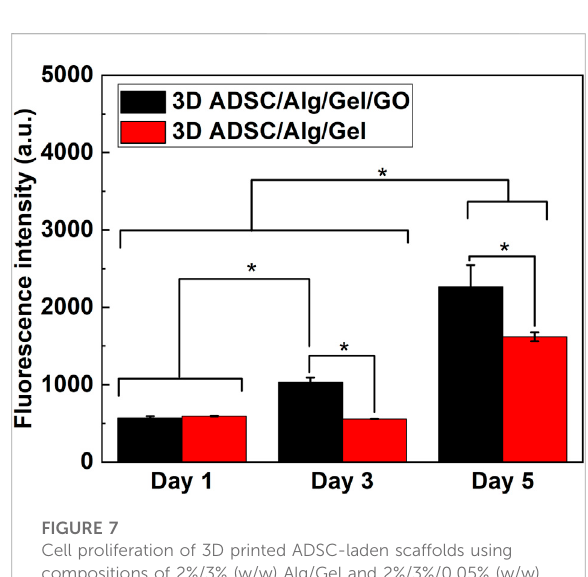
FIGURE 7 Cell proliferation of 3D printed ADSC-laden scaffolds